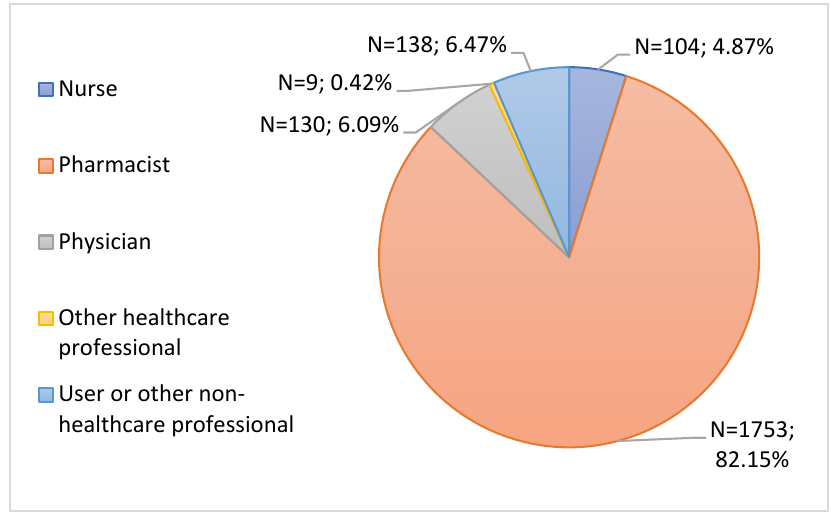
Figure 1. Characterization of notifications by type of notifier.